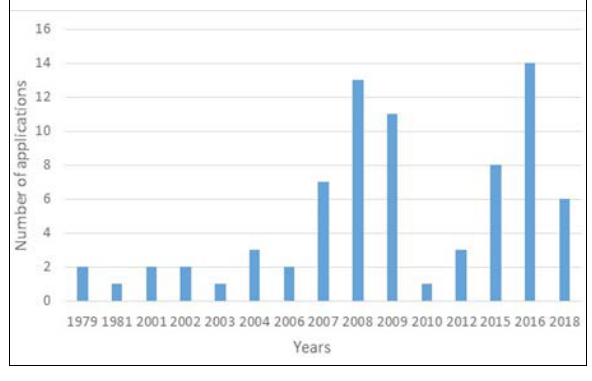
Annual applications for sunflower varietal improvements by plant breeders, 1979–2019.